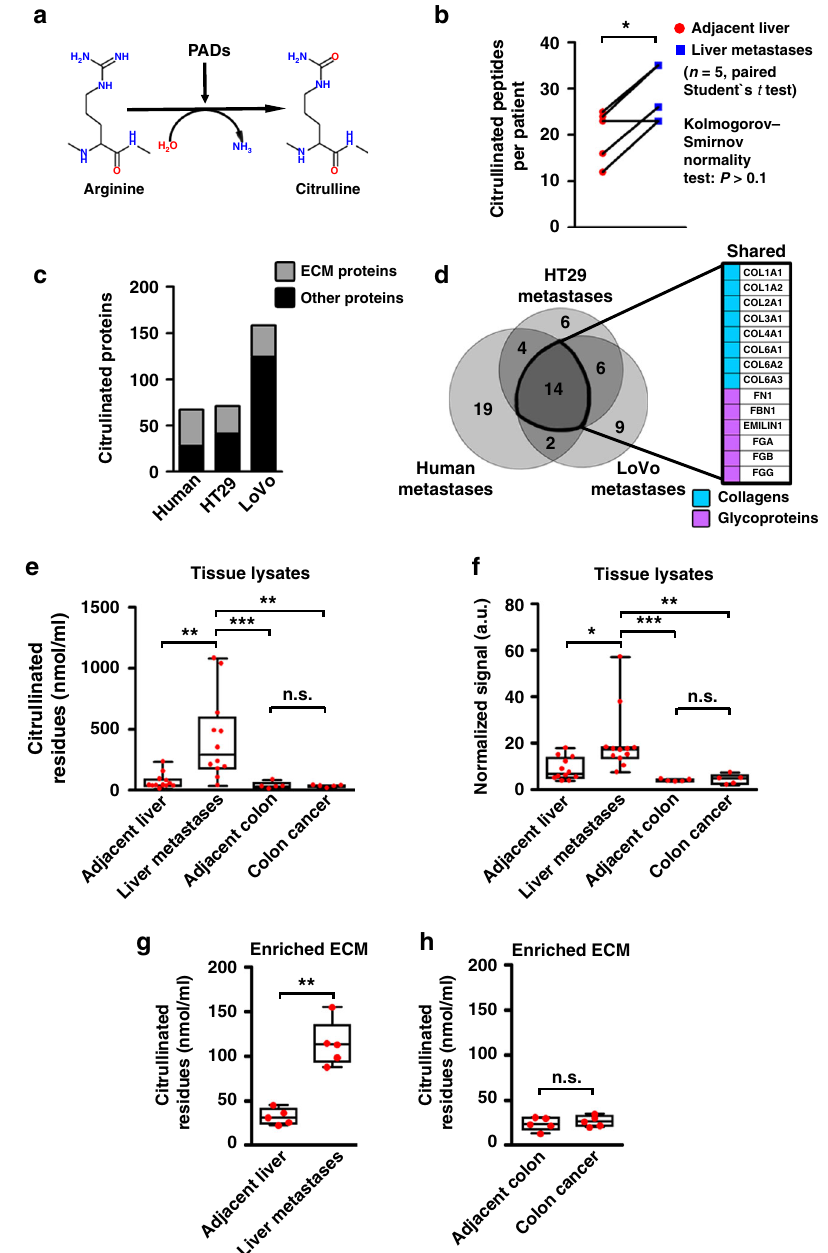
Fig. 2 ECM proteins in human CRC hepatic metastases are extensively citrullinated. a Schematic of PAD-mediated modi fi cation of arginine to citrulline residues. b Quanti fi cation of citrullinated peptides identi fi ed by LC-MS/MS in the enriched ECM from CRC hepatic metastases and paired adjacent unaffected liver tissues ( n = 5 per group). c Quanti fi cation of citrullinated proteins (categorized as ECM proteins or other proteins) identi fi ed in the ECM from human CRC liver metastasis tissues ( n = 5) and ECM of experimental liver metastases generated using HT29 ( n = 2 biological replicates) and LoVo ( n = 2 biological replicates) CRC cells. d Venn diagram demonstrating an overlap of citrullinated ECM proteins identi fi ed in human and experimental CRC hepatic metastases from c . Shared proteins are listed in the box to the right. e ELISA for citrullinated proteins was performed on tissue lysates of human CRC hepatic metastases, paired adjacent unaffected liver tissues ( n = 12 per group), human primary CRC lesions and paired adjacent unaffected colon tissues ( n = 5 per group). Representative of two experiments. f Densitometry analysis of immunoblotting for citrullinated proteins performed on tissue lysates extracted from patients with CRC hepatic metastases and paired adjacent unaffected liver tissues ( n = 12 per group) and patients with primary colon adenocarcinomas and paired adjacent unaffected colon tissues ( n = 5). For the densitometry, the sum of all bands was used. Densitometry results were normalized to loading control. Representative of two experiments. g , h ELISA for citrullinated proteins was performed on decellularized and biochemically enriched ECM from human CRC hepatic metastases, paired adjacent unaffected liver tissues ( n = 5 per group) ( g ), and human primary CRC lesions and paired adjacent unaffected colon tissues ( n = 5 per group) ( h ). Experiment was performed once. Throughout, error bars indicate range, box bounds indicate second and third quartiles, center values indicate median. * P < 0.05, ** P < 0.01, *** P < 0.001, n.s. = non-signi fi cant, paired Student ’ s t test for b ( P > 0.1 for Kolmogoro – Smirnov normality test), Mann – Whitney U test for g and h , and Kruskal – Wallis test with Dunn ’ s post-test for e and f .